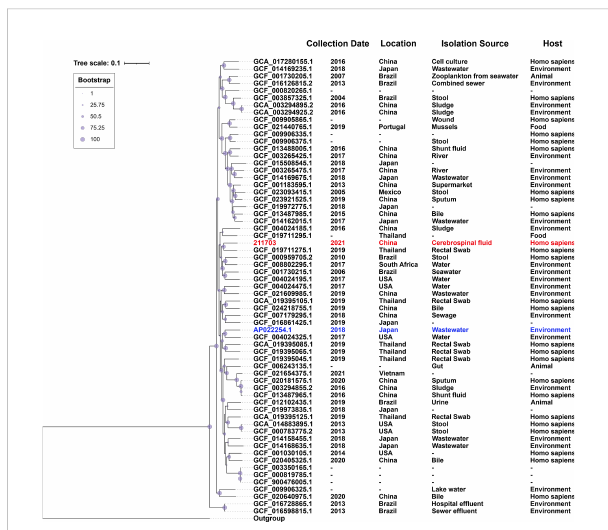
FIGURE 1 Population distribution of A. caviae 211703 with 62 A. caviae genomes. The phylogenetic tree was constructed by the Maximum- likelihood method. The degree of support (percentage) for each cluster of associated taxa, as determined by bootstrap analysis, was shown with blue dots next to each branch. The bar corresponded to the scale of sequence divergence. 211703 was indicated in red and AP022254.1 was indicated in